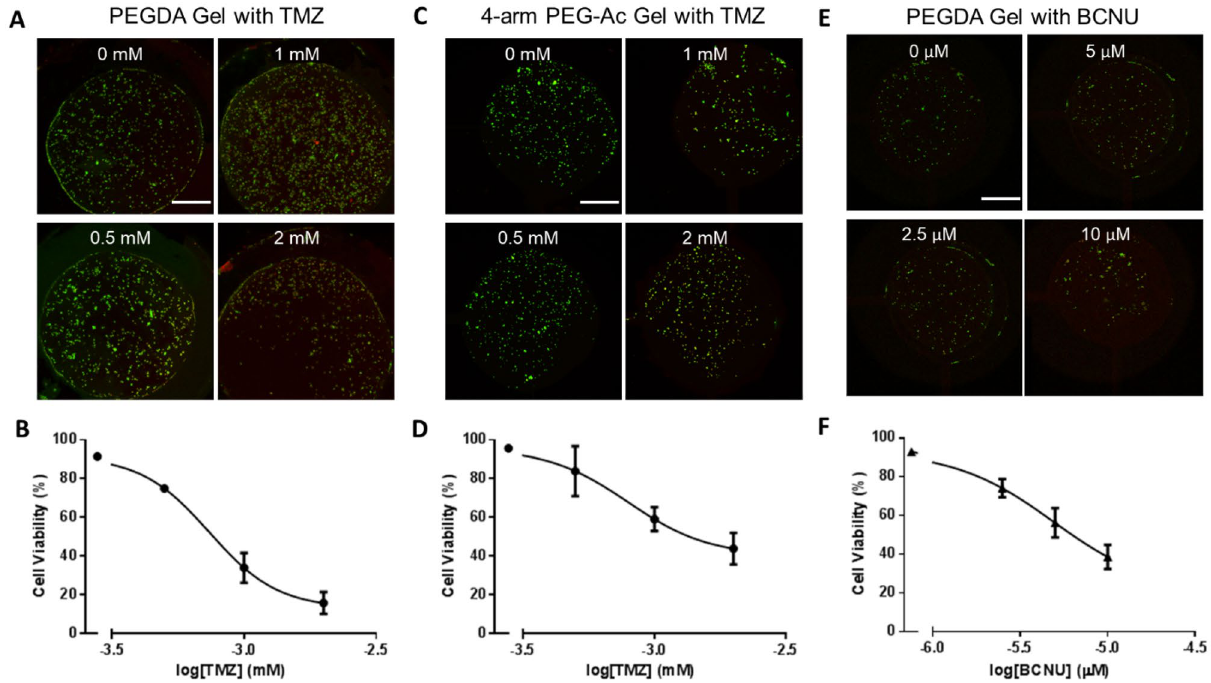
Figure 6. Drug responsiveness. ( A ) Representative U87 cell live/dead images upon TMZ treatment, and ( B ) cell viability as a function of TMZ concentration (n = 3) for cells seeded in a non-degradable, non-adhesive PEGDA gel. ( C ) Representative U87 cell live/dead images upon TMZ treatment, and ( D ) cell viability as a function of TMZ concentration (n = 3) for cells seeded in a degradable, adhesive 4-arm PEG-Ac gel. ( E ) Representative U87 cell live/dead images upon BCNU treatment, and ( F ) cell viability as a function of BCNU concentration (n = 3) for cells seeded in a non-degradable, non-adhesive PEGDA gel. All cells were stained with DiOC (green) and dead cells were stained with PI (red). Scale bar is 200